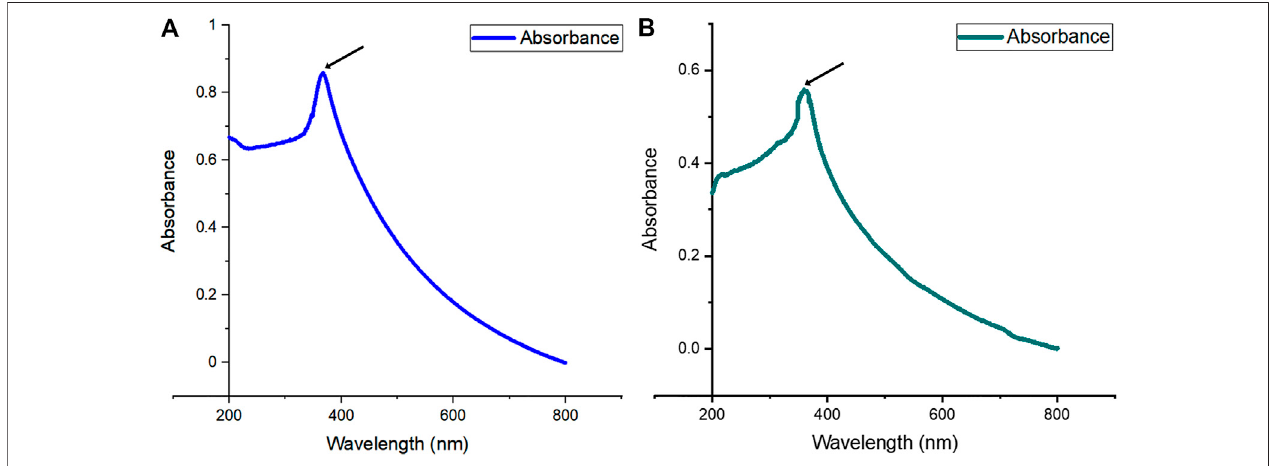
FIGURE 2 | UV-visible (UV-vis) absorption spectra of biogenic ZnO-NPs (from 200 to 800-nm wavelength). (A) Ethanol extract of S. chirayita leaves and (B) methanol extract of S. chirayita leaves. Analysis was done using Origin software.